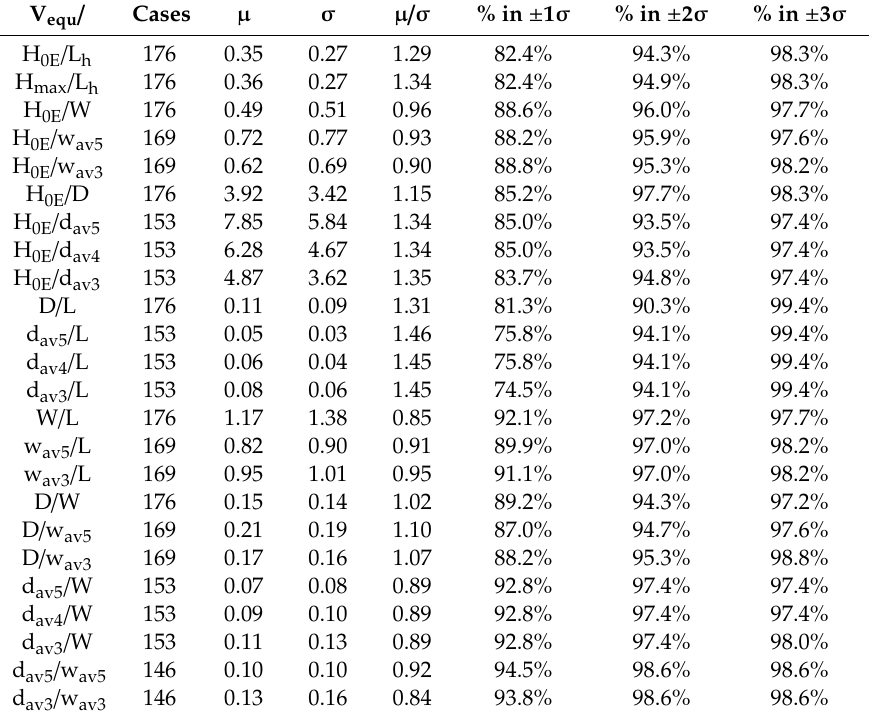
Table 5. Results for volume-to-ratio correlations for the set “full”. For all shape-related parameters (i.e., here the ratios), the mean values ( µ ) with the respective standard deviations ( σ ) and the sample sizes per sigma interval are